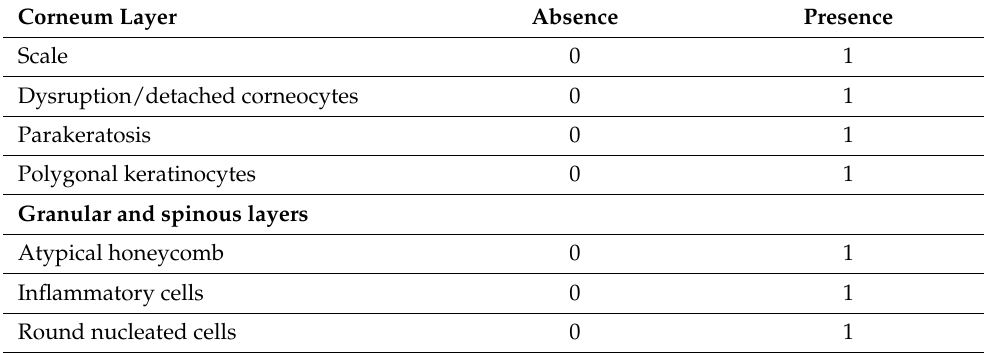
Table 4. Reflectance confocal microscopy parameters used for the definition of a score for the target lesion and the field of cancerization of each patient before and after